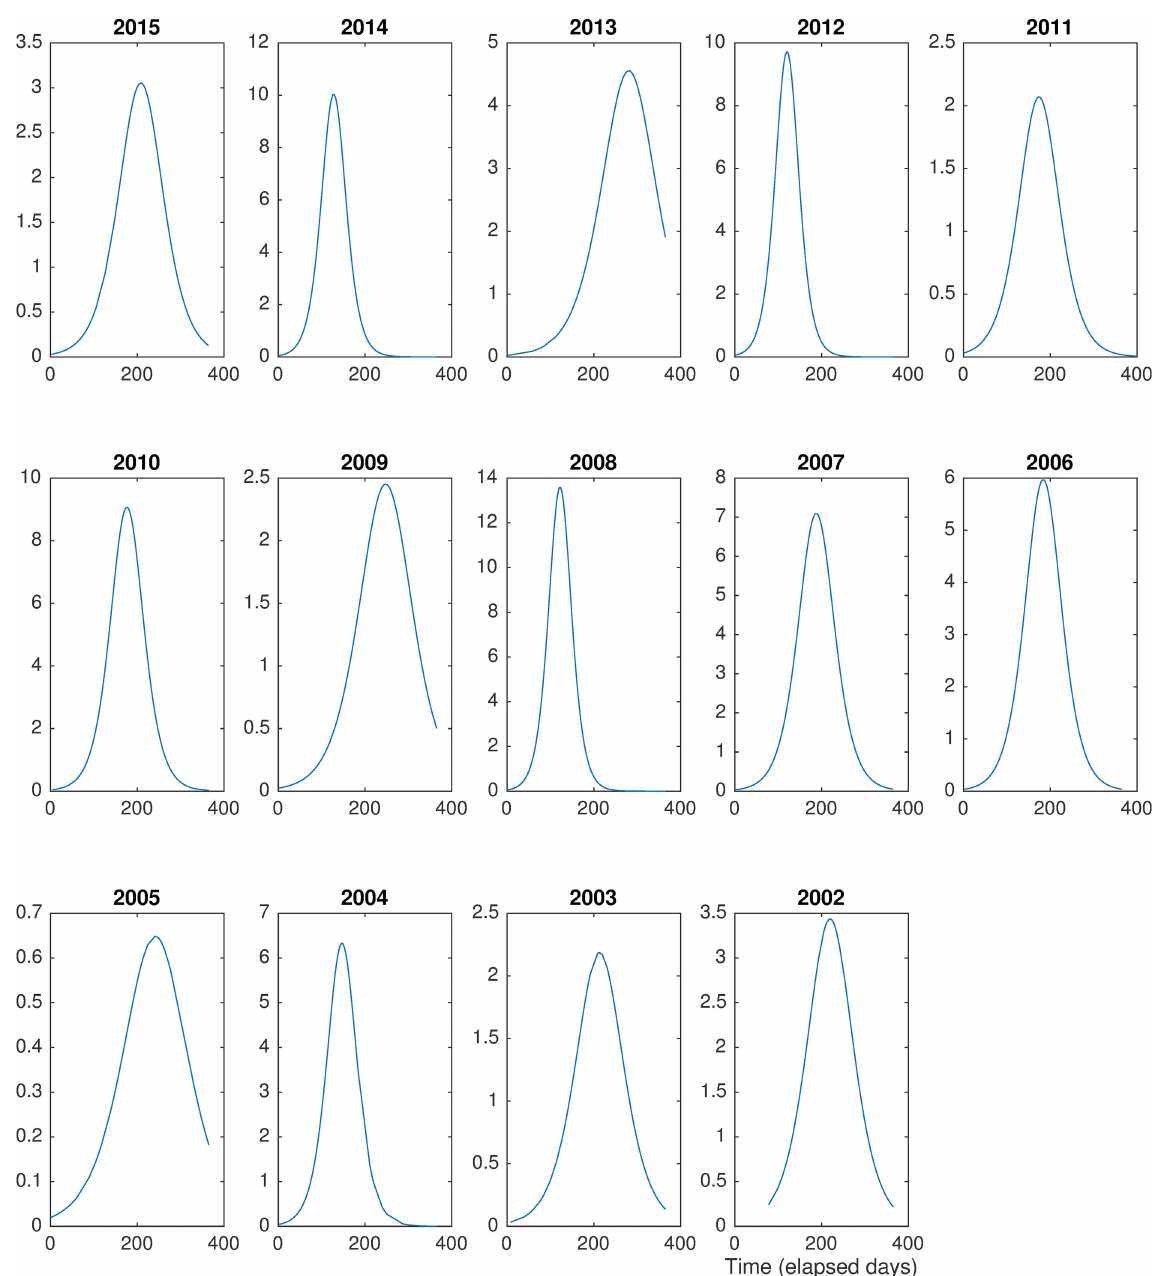
(cid:1) Fig 4. Derivative of the number of credit operations ( N ð t Þ ). Clear peaks are observedaroundthe middleof each year. Moreover, tails of the function are in line with proposed model whileindicatinga periodof acceleration at first and a periodof relaxationat the end of the year. Empirical derivativeswere estimated via central finite